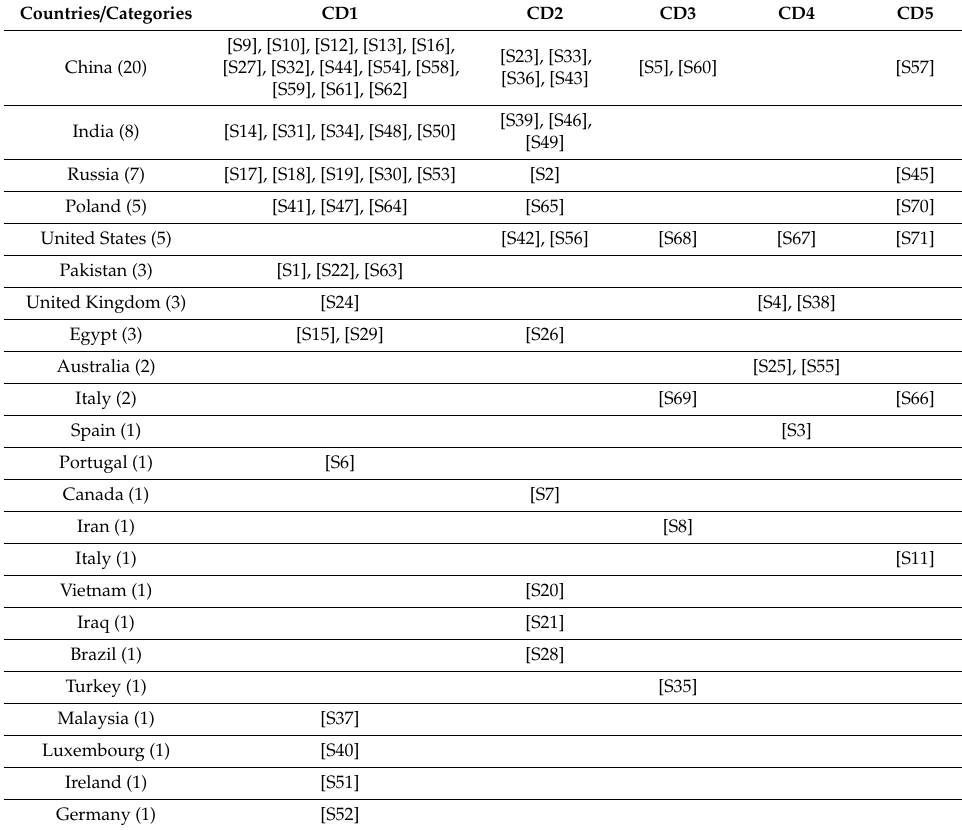
Figure 3. Number of selected studies published per year. Table 8. Study distribution by countries and application domain